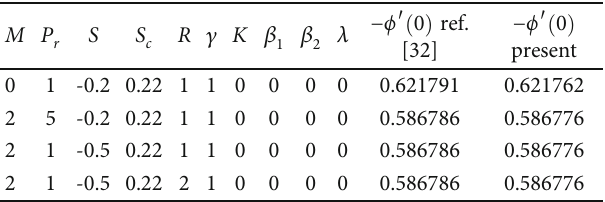
Table 4: Values of local Sherwood number in comparison between current study and previous study ref.